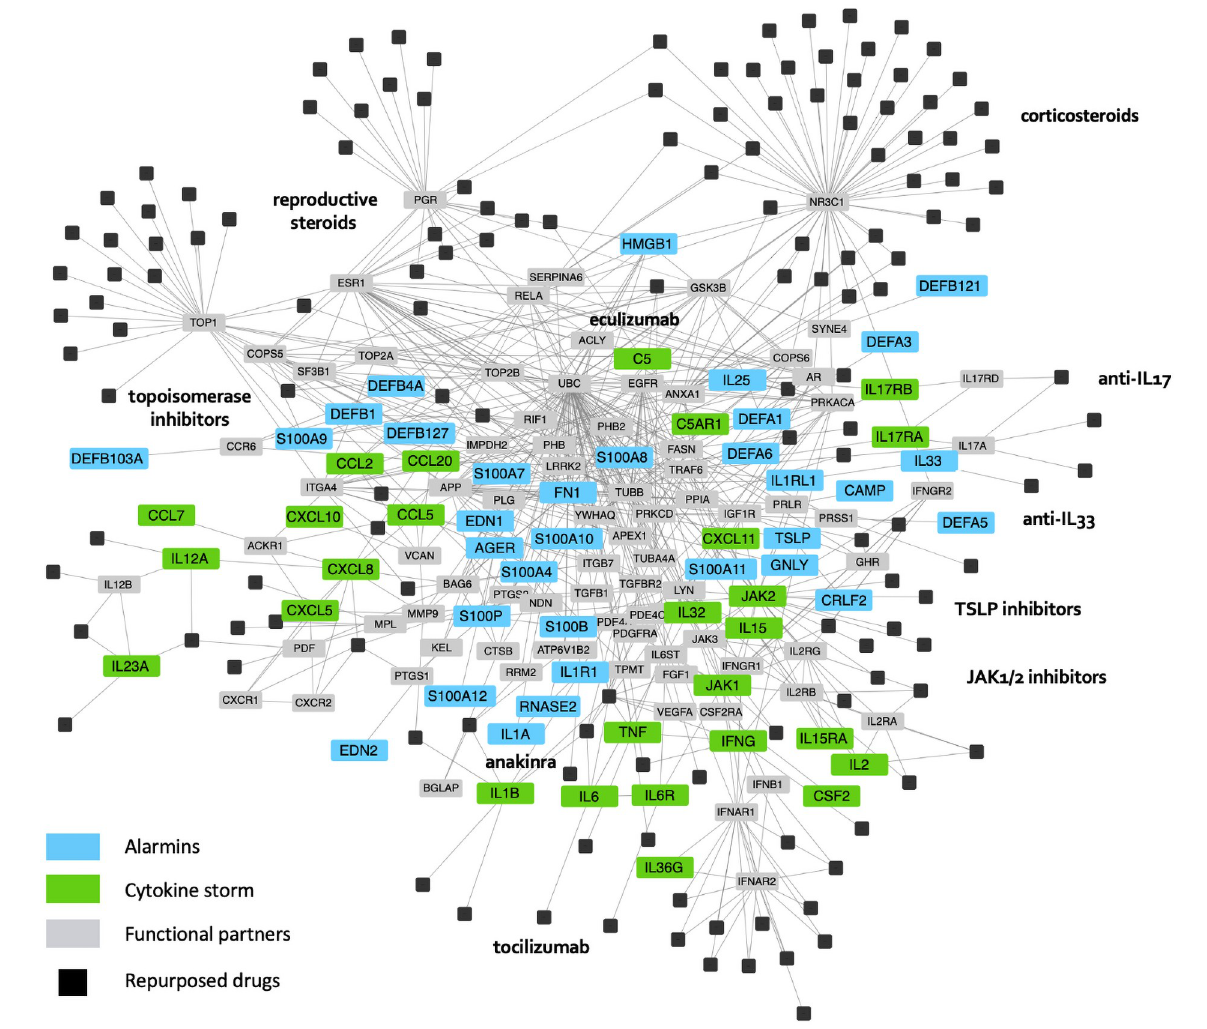
Fig 4. Druggable interactome of proteins contributing to lung inflammation in COVID-19. Extraction of the interactome encompassing proteins predicted to contribute to COVID-19 evolution towards a cytokine storm. Following SARS-CoV-2 infection of lung tissues and ensuing activation of innate and adaptive immune cells, different categories of proteins represent potential therapeutic targets to prevent or slow down lung inflammation associated with severe COVID-19. The latter include Alarmins , as well as cytokines, chemokines and selected proinflammatory factors associated with the Cytokine storm . For clarity, this figure only displays the disease related proteins (Alarmins & Cytokine storm) identified in our model, our top ranking repurposed drugs as well as some functional partners. The latter represent additional proteins needed in order to form a minimal principal component